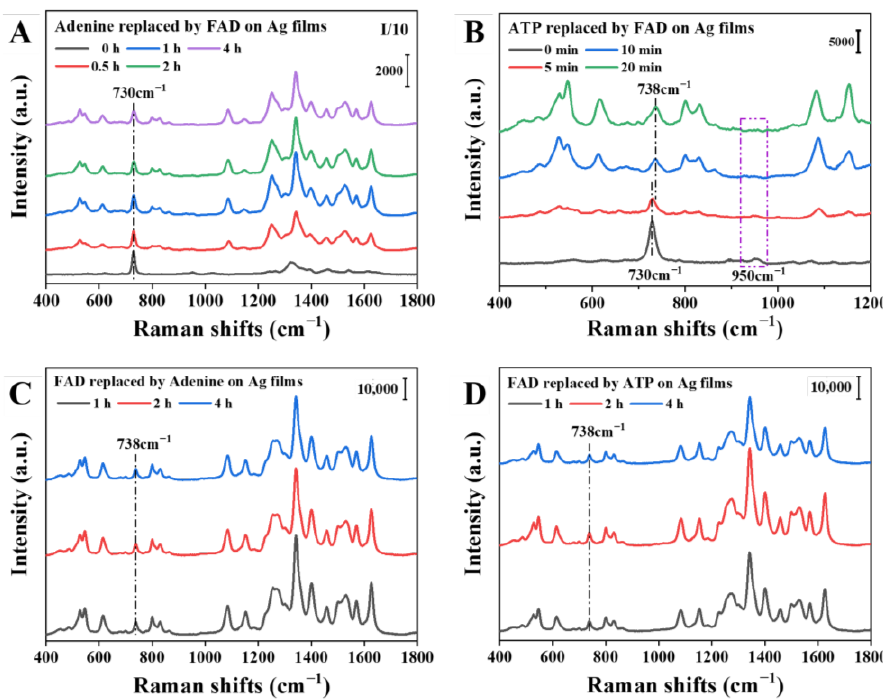
Figure 6. The 532-nanometer-laser Raman spectra of adenine ( A ) and ATP ( B ) replaced by FAD on Ag nanofilms, respectively, and the 532-nanometer-laser Raman spectra of FAD replaced by adenine ( C ) and ATP ( D ) on Ag nanofilms, respectively. The replacement time were marked above the color line.